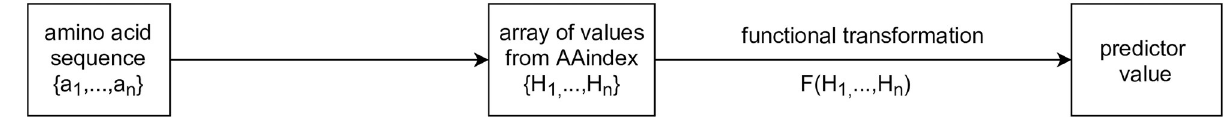
PLOS ONE | https://doi.org/10.1371/journal.pone.0239793 May 20,